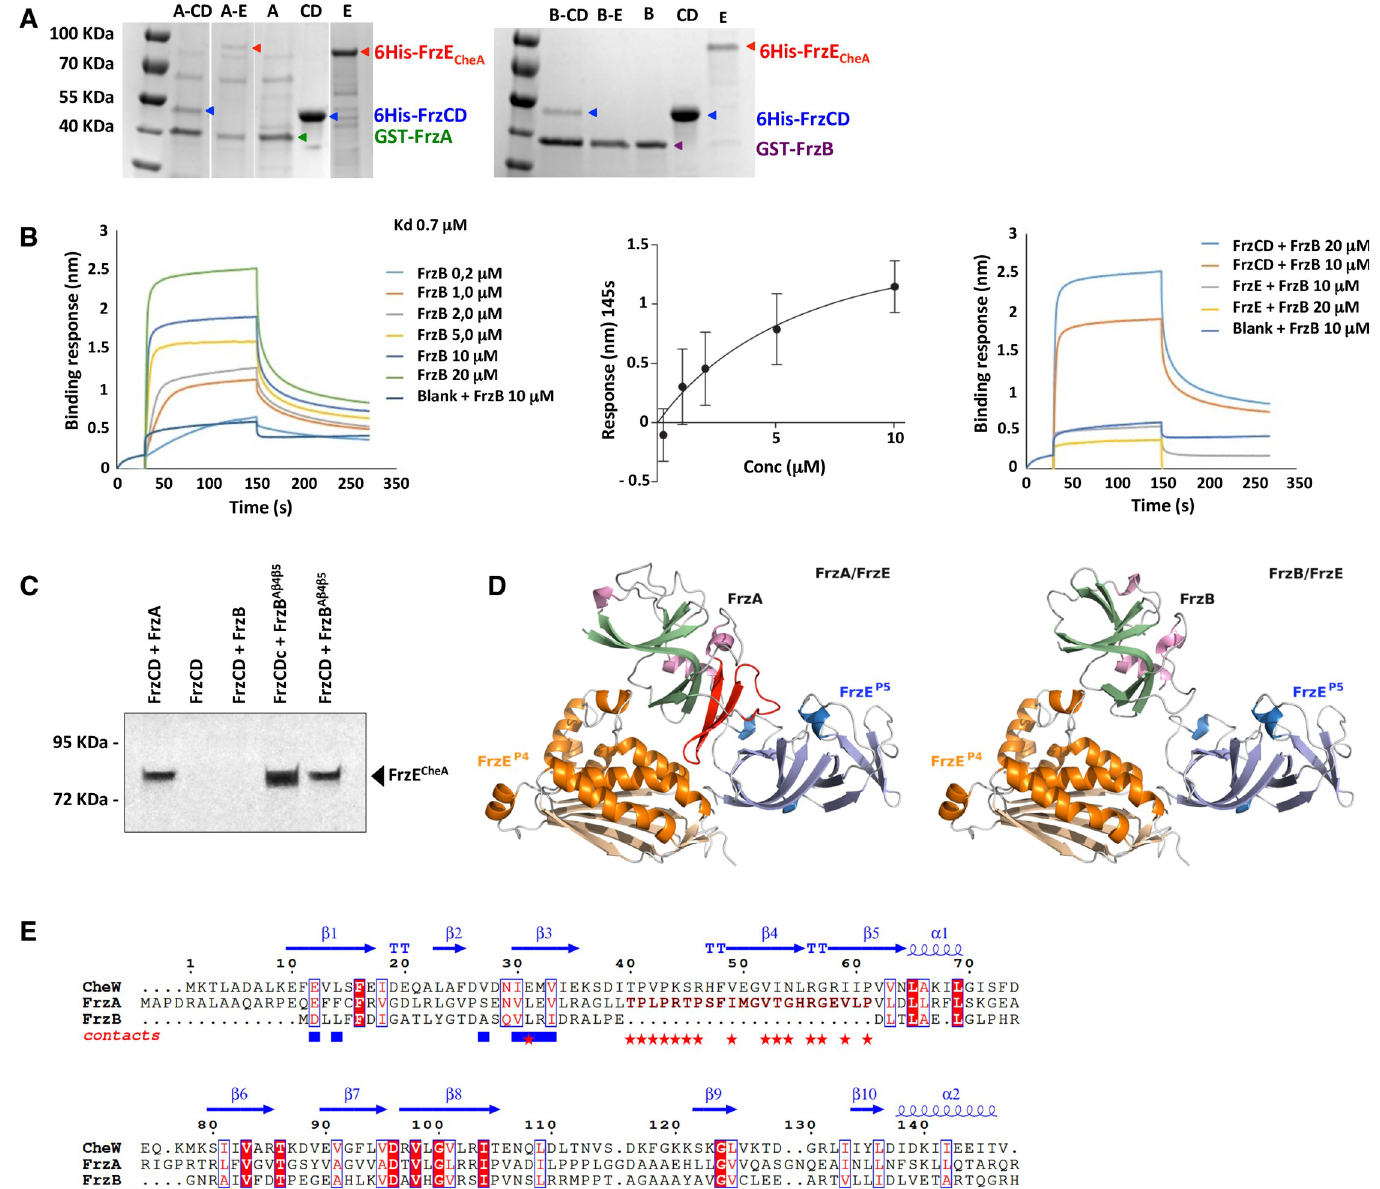
Fig 3. Interaction of FrzB with FrzCD and FrzE. (A) GST affinity chromatography co-purification of the indicated pairs. A, B, CD and E stand for GST-FrzA, GST-FrzB, 6His-FrzCD and 6His-FrzE CheA , respectively. In the first gel, lanes are issued from the same gel and were grouped for simplicity. (B) In the left panel, BLi sensograms show the binding of different amounts of GST-FrzB with immobilized 6His-FrzCD. BlitZ ProTM was used to calculate the affinity constant (Kd = 0.7 μ M), using a global 1:1 fit. The central panel shows the responses at 145 s (nm, x axis) (average of two biological replicates) of the binding of immobilized 6His-FrzCD with different concentrations of GST-FrzB ( μ M, y axis). Data were analyzed by GraphPad Prism 5.0, based on steady-state levels of the responses. In the right panel, BLi sensograms show the binding of different amounts of GST-FrzB with immobilized 6His-FrzCD or 6His-FrzE CheA for comparison. A reference subtraction (sensor reference and GST-FrzB at 10 μ M) was applied to account for non-specific binding, background, and signal drift to minimize sensor variability. (C) The effect of the FrzB β 4- β 5 chimera on the FrzE phosphorylation. The FrzE kinase domain (FrzE CheA ) auto-phosphorylation was tested in vitro by incubation of FrzE CheA in the presence of FrzA, FrzB or FrzB β 4- β 5 , the indicated different forms of FrzCD and ATP γ P 33 as a phosphate donor. (D) 3D models of the FrzE P4-P5 :FrzA and FrzE P4-P5 :FrzB complexes based on the T . maritima CheA P4-P5 :CheW crystal structure (PDB 2ch4). The 20 amino acid region forming the β -strands 4 and 5 of subdomain 2 and corresponding to the CheW region important for the CheW:CheA P5 interaction are highlighted in red in the FrzA structure. These residues are missing in FrzB. (E) Protein structural alignments between the T . maritima CheW x-ray structure and M . xanthus FrzA and FrzB theoretical 3D models. CheW residues in atomic contact with CheA and MCP are shown as red stars and blue squares, respectively. Secondary structures determined from CheW x-ray structure are shown on top of the alignment.